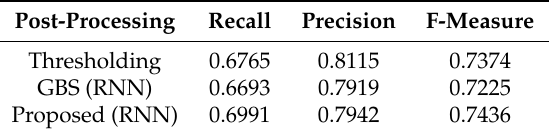
Table 3. Transcription results on the real piano “ENSTDkCl”.